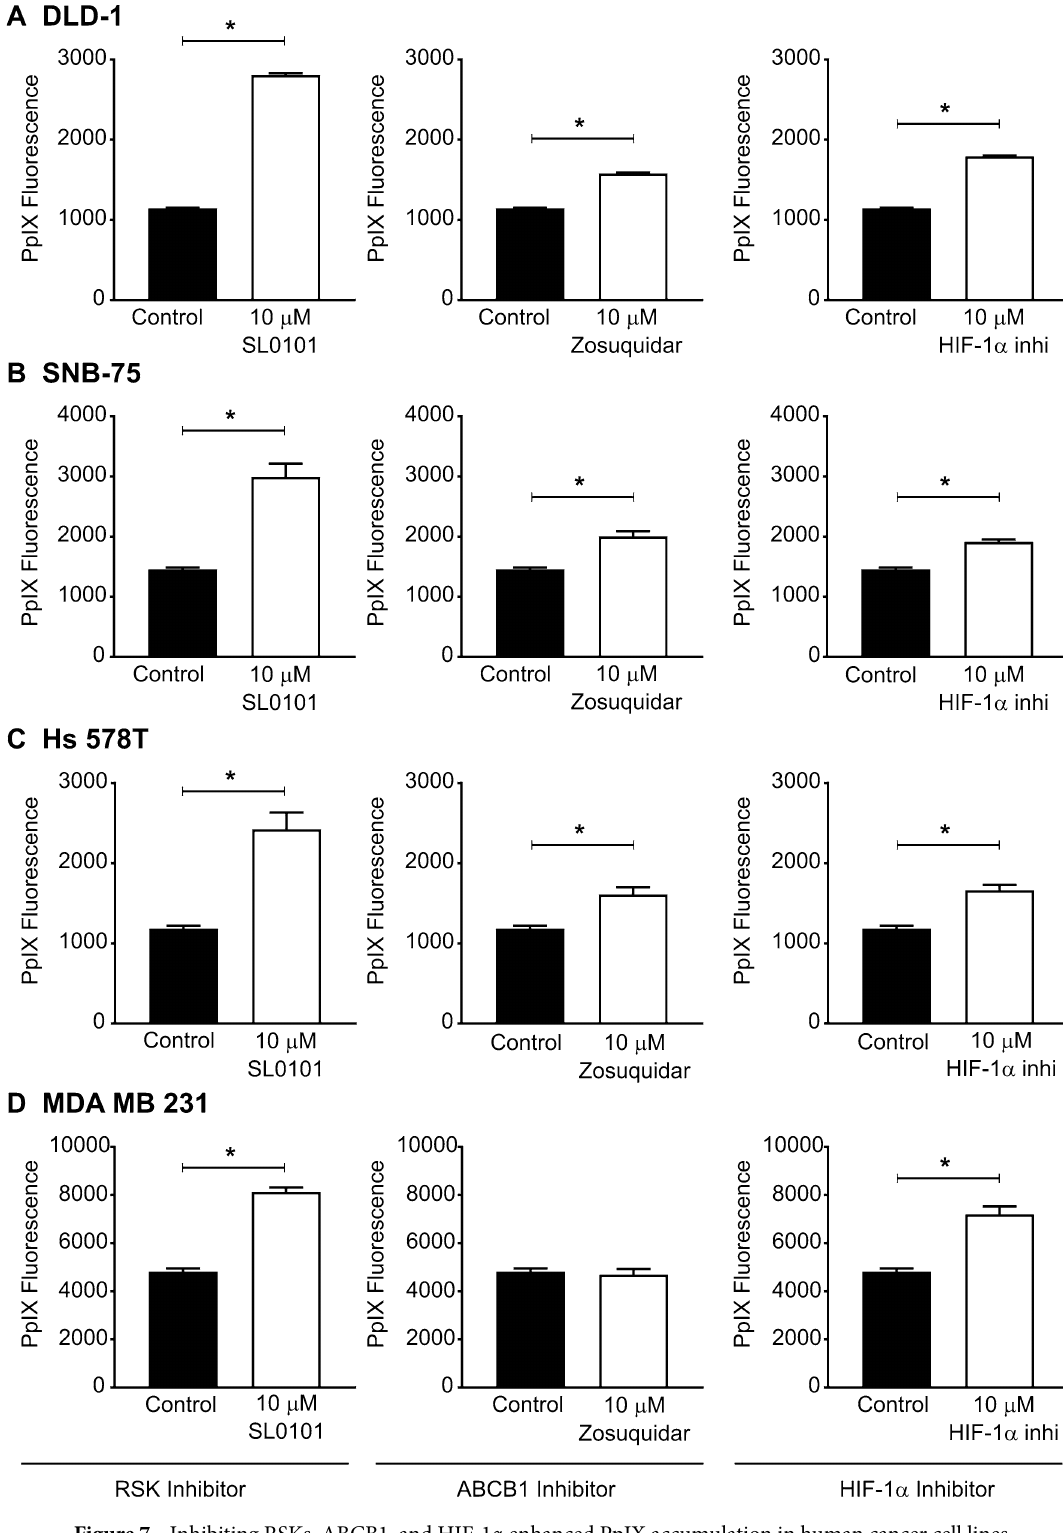
Figure 7. Inhibiting RSKs, ABCB1, and HIF-1α enhanced PpIX accumulation in human cancer cell lines. Human cancer cell lines DLD-1, SNB-75, Hs 578 T, and MDA MB 231 were pre-treated with or without SL0101 (RSK inhibitor), Zosuquidar (ABCB1 inhibitor), or HIF 1α inhibitor for 20 h and then with 5-ALA for 4 h. Mean ± SEM PpIX fluorescence in cell lysate compared to controls is shown. *p < 0.01 by Student’s t